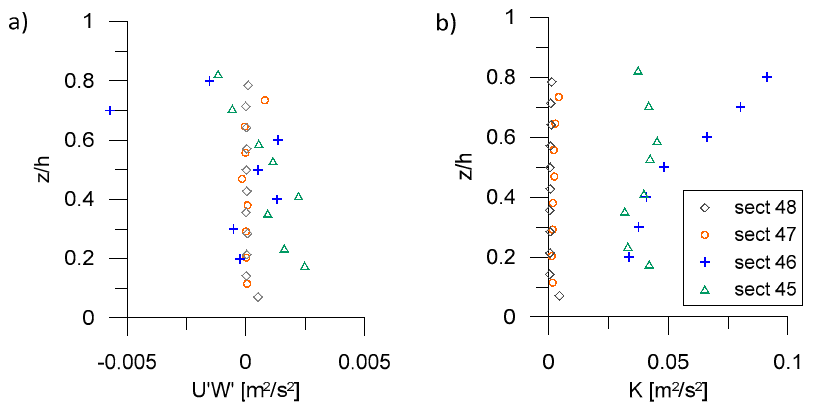
Figure 4. Test_P: vertical profiles of the time-averaged turbulent Reynolds stresses ( a ) and turbulent kinetic energy ( b